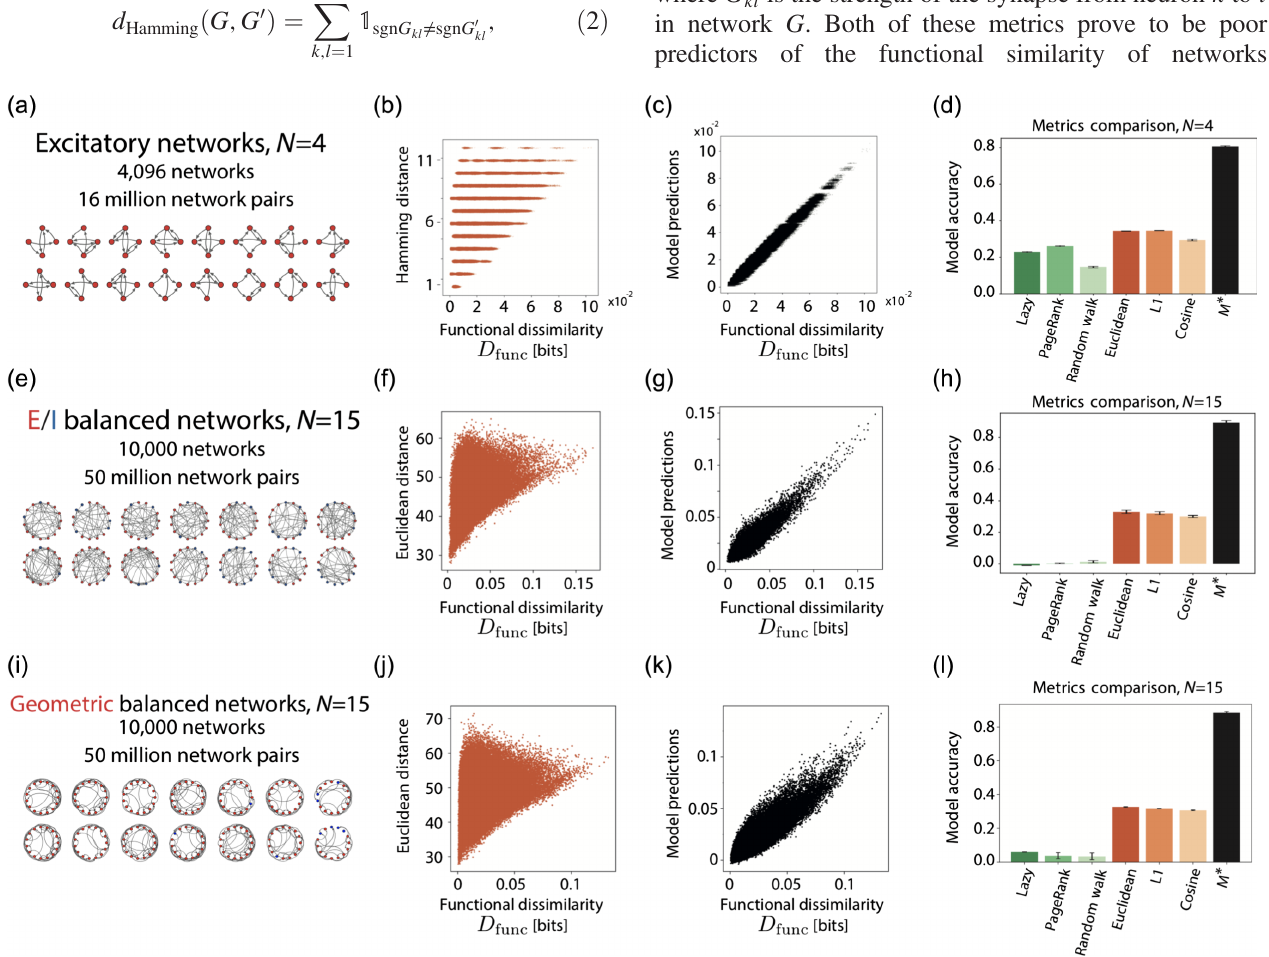
FIG. 2. Common structural metrics fail to predict the functional similarity between networks of neurons, whereas a learned bilinear metric succeeds. (a) The first simulated ensemble, consisting of 4096 networks of four neurons with constant weights. (b) Hamming distances between all pairs of 4096 networks of size N ¼ 4 are plotted against the computed D between networks ( y values are func slightly jittered to show the density of points). We note the points in the upper-left correspond to pairs of networks that have almost no overlap in terms of synaptic connections yet are functionally very similar. (c) Predictions of the bilinear model on held-out test data, i.e., networks that are not used in finding M (cid:3) . (d) We compare the prediction accuracy of different structural metrics for networks of size N ¼ 4 , by computing the mean Pearson correlation of their predictions with the functional dissimilarity of the networks D (averaged func over 30 different initial conditions). Our learned model (black) outperforms multiple graph-based models (green) and vector-based ones (orange). Error bars represent one standard deviation. (e) The second simulated ensemble, consisting of 10 000 networks of 15 neurons with balanced excitatory and inhibitory weights (on average). (f) – (h) The same as (b) – (d) but for an ensemble of networks with N ¼ 15 . Since synaptic weights in this ensemble are continuous, the Euclidean distance between synaptic weights is used instead of Hamming (see the main text). (i) This simulated ensemble consists of 10 000 “ geometric ” networks, each with 15 neurons with both excitatory and inhibitory weights that are balanced (on average), but with distance-dependent connectivity (see the main text). (j) – (l) The same as (f) – (h) but for the ensemble of geometric